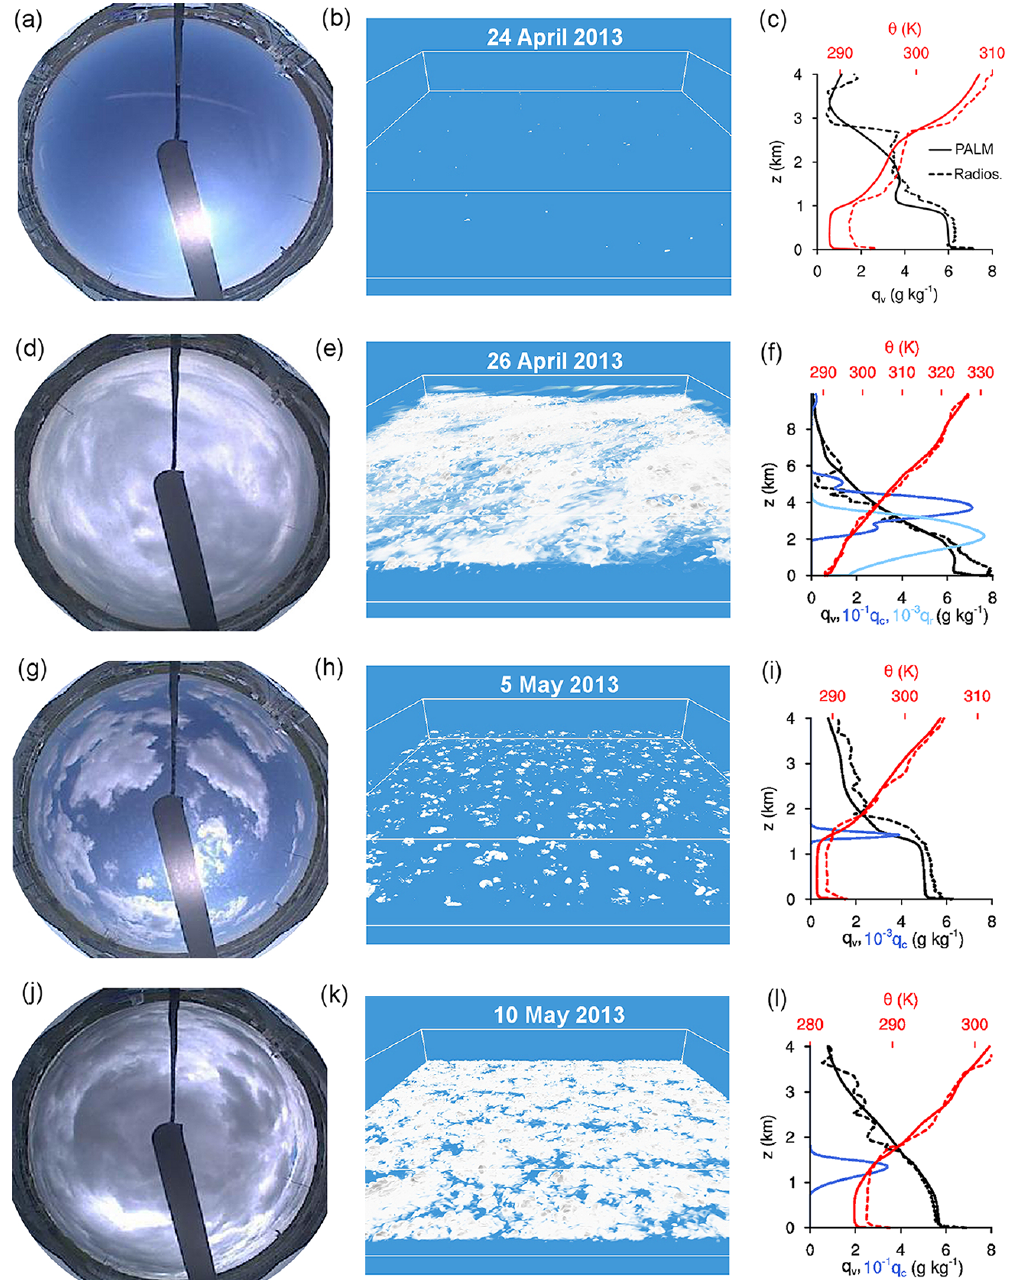
Figure 3. Snapshots and mean profiles of four different days (24 April, 26 April, 5 May and 10 May) taken at 11:00UTC. The left column (a, d, g, j) shows images taken with the Total Sky Imager TSI-880 at the JOYCE site, the middle column (b, e, h, k) shows volume-rendered cloud water mixing ratio q c of the PALM reference simulation RP, and the right column (c, f, i, l) shows mean profiles of mixing ratio q v (black), potential temperature θ (red), cloud and rainwater mixing ratios q c (blue), and q r (light blue), respectively. The solid lines are horizontally averaged profiles of RP and the dashed lines are profiles from radio soundings (radios.) launched at the KITcube site. Note that the vertical axis in (f) extends up to